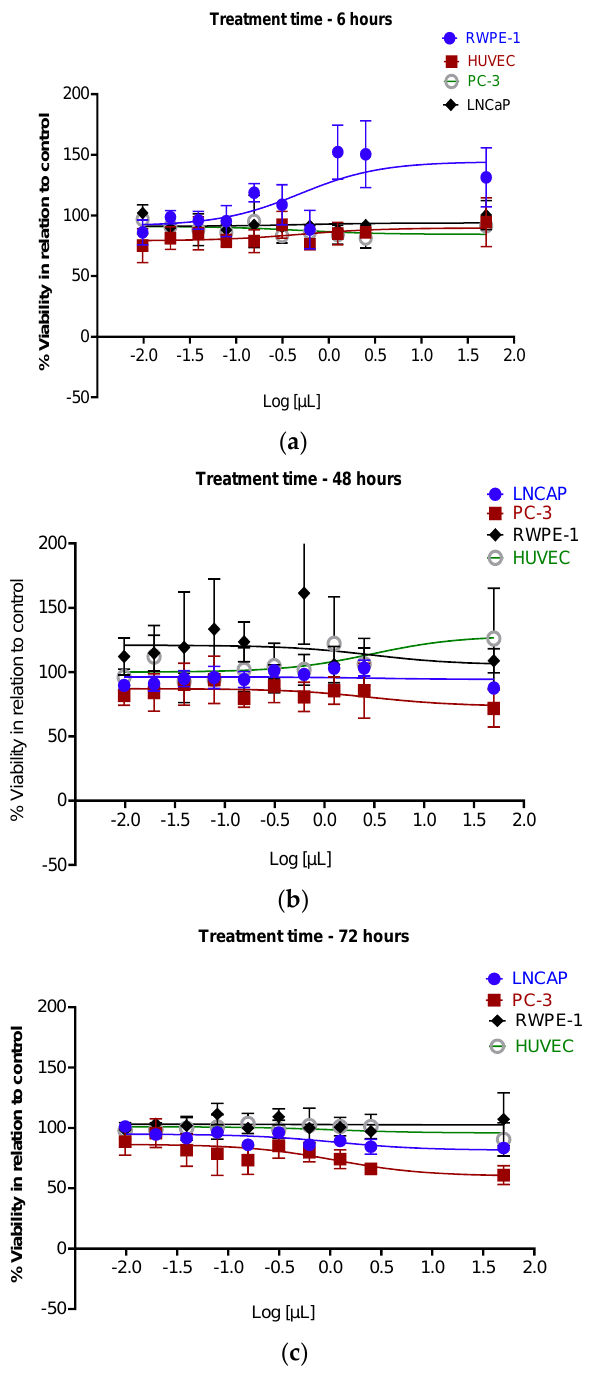
Figure 4. Sulforodamine B viability assay showing LNCaP, PC-3, RWPE-1, and HUVEC cells viability under the treatment of AuNPs for 6 h ( a ), 48 h ( b ), and 72 h ( c ), then cultured for an additional 72 h, were determined as a percentage of viable cells relative to control (cells with no NPs treatment). The volume used ranged from 0.01 to 20 µL corresponding to 2.4 × 10 6 to 4.8 × 10 9 AuNPs.